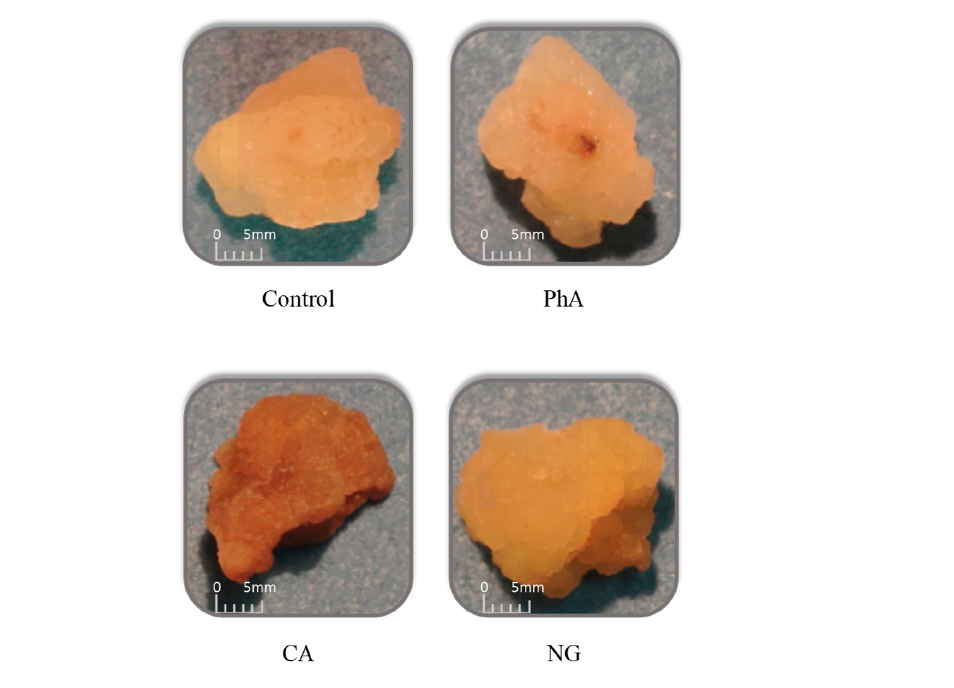
Figure 1. The tea callus cultures grown on the liquid Heller culture medium of the basic composition (Control) or enriched with L -phenylalanine (PhA; 3 mM), trans -cinnamic acid (CA; 1 mM) or naringenin (NG; 0.5 mM). Callus culture age—9 days.